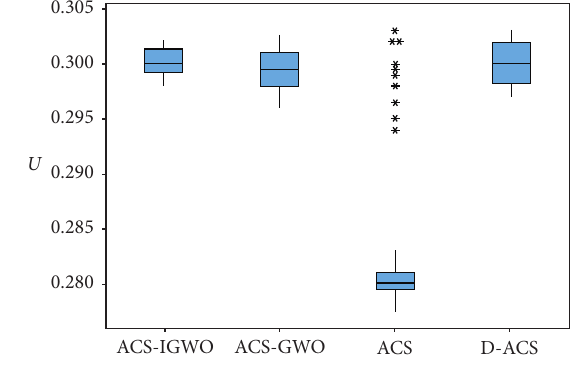
Figure 10: Box plot of example II.